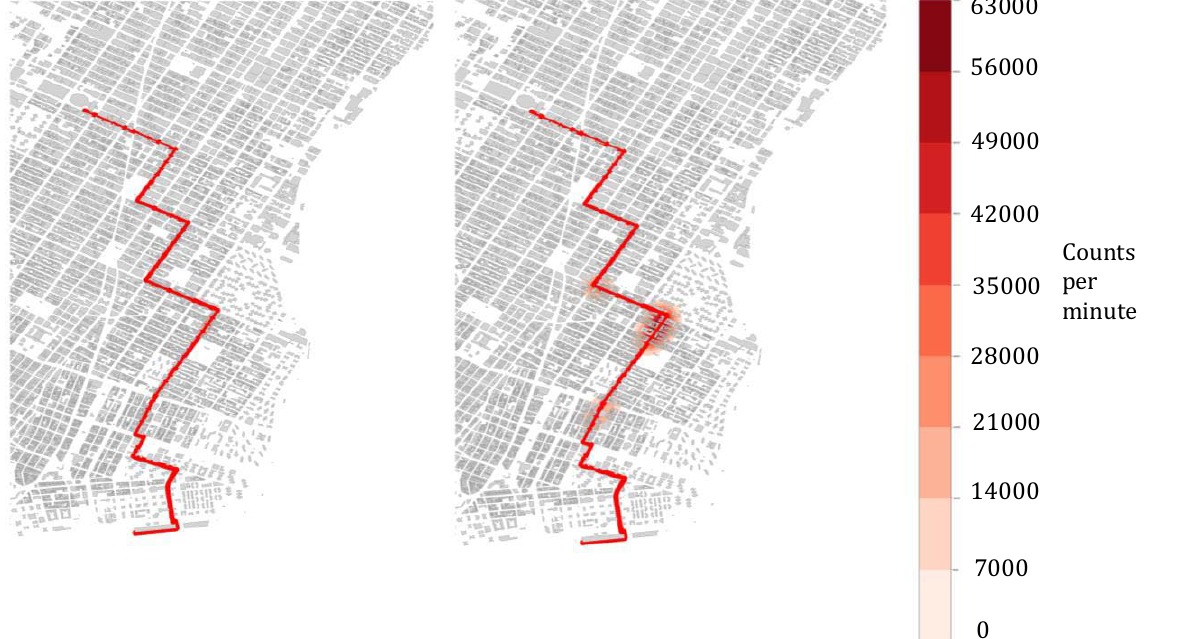
Figure 3. Detection heat maps. Maps show counts per minute detected for a 400-vehicle mobile detector array of a 0.1 Ci Co-60 (left) and a 0.5 Ci Co-60 (right) source moving at